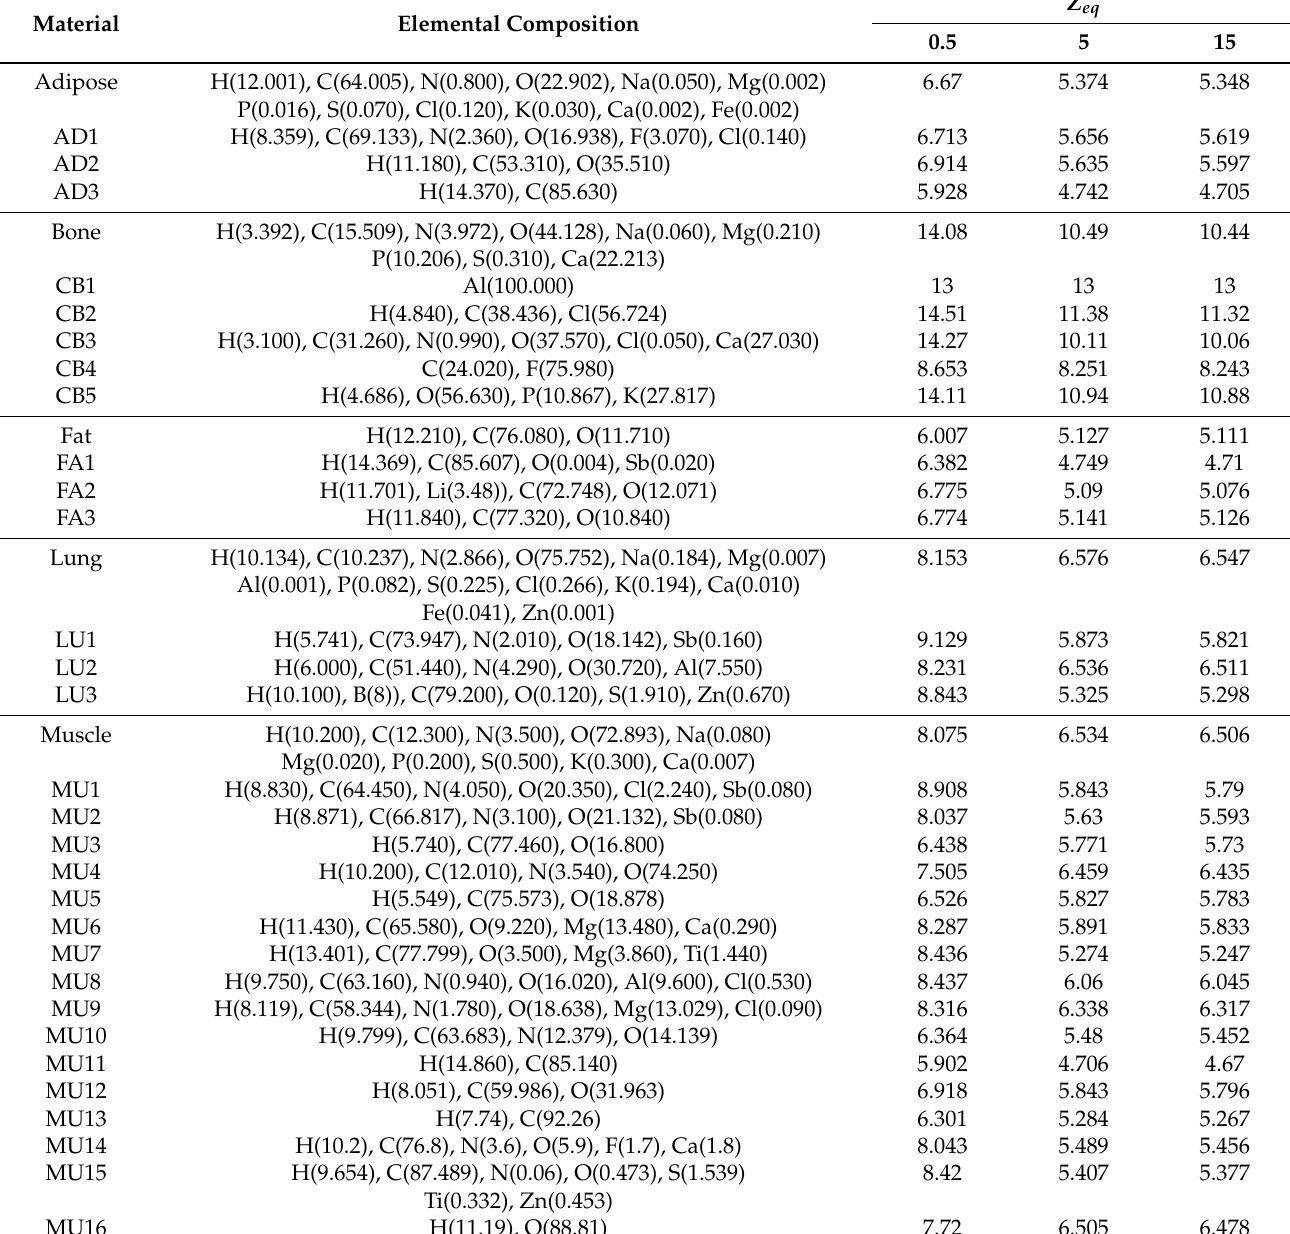
Table 1. Percentage elemental composition and equivalent atomic number (for three photon energies in MeV) of studied tissues and their mimicking material